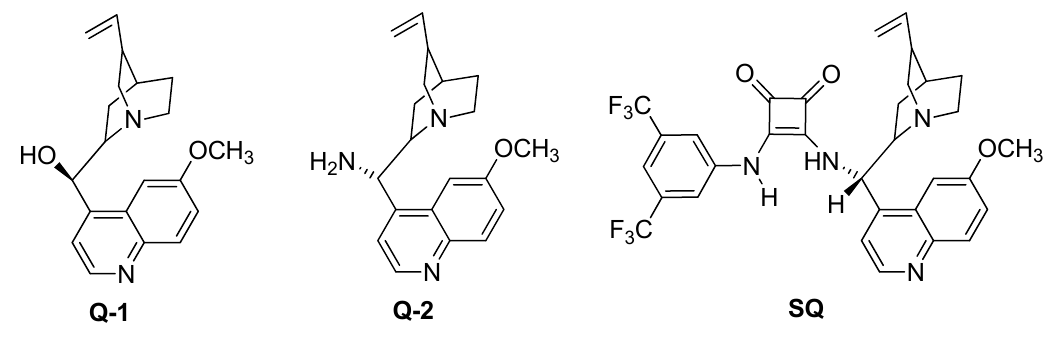
Figure 1. Structures of commercial cinchona alkaloid catalysts.